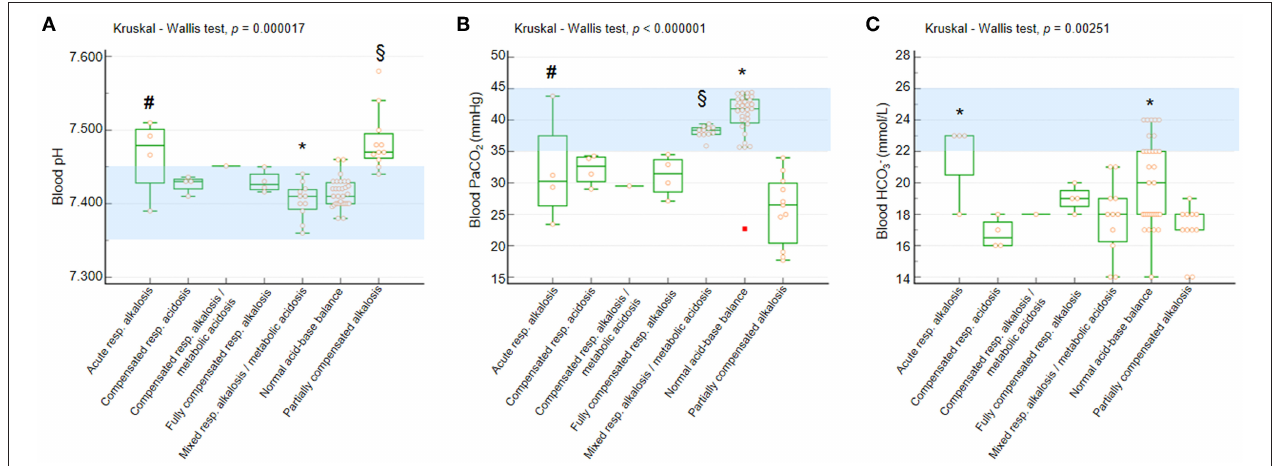
FIGURE 2 | Blood pH, PaCO 2 , and HCO − 3 in the whole population with RTT as a function of acid-base balance patterns. (A) Blood pH. Post-hoc analysis (Conover test): * p < 0.05 vs. all the other categories with the single exception of normal acid-base balance. § vs. compensated respiratory alkalosis + metabolic acidosis, fully compensated respiratory alkalosis, mixed respiratory alkalosis/metabolic acidosis, and normal acid-base balance. # vs. normal acid-base balance. (B) Blood PaCO 2 . Post-hoc analysis (Conover test):* p < 0.05 vs. all the other categories. § vs. compensated respiratory alkalosis + metabolic acidosis, fully compensated respiratory alkalosis, and partially compensated respiratory alkalosis. # vs. partially compensated respiratory alkalosis and normal acid-base balance. (C) Blood HCO − 3 . Post-hoc analysis (Conover test): * p < 0.05 vs. compensated respiratory alkalosis + metabolic acidosis, mixed respiratory alkalosis/metabolic acidosis, and partially compensated respiratory alkalosis. § vs. compensated respiratory alkalosis + metabolic acidosis and partially compensated respiratory alkalosis. PaCO 2 , partial arterial pressure of carbon dioxide; HCO − 3 , arterial bicarbonate. Data are shown as box and whisker plots. Bars represent medians and inter-quartile ranges. Red rectangle indicates outlier data point. Normal range values (consensus definitions) are highlighted in light blue.